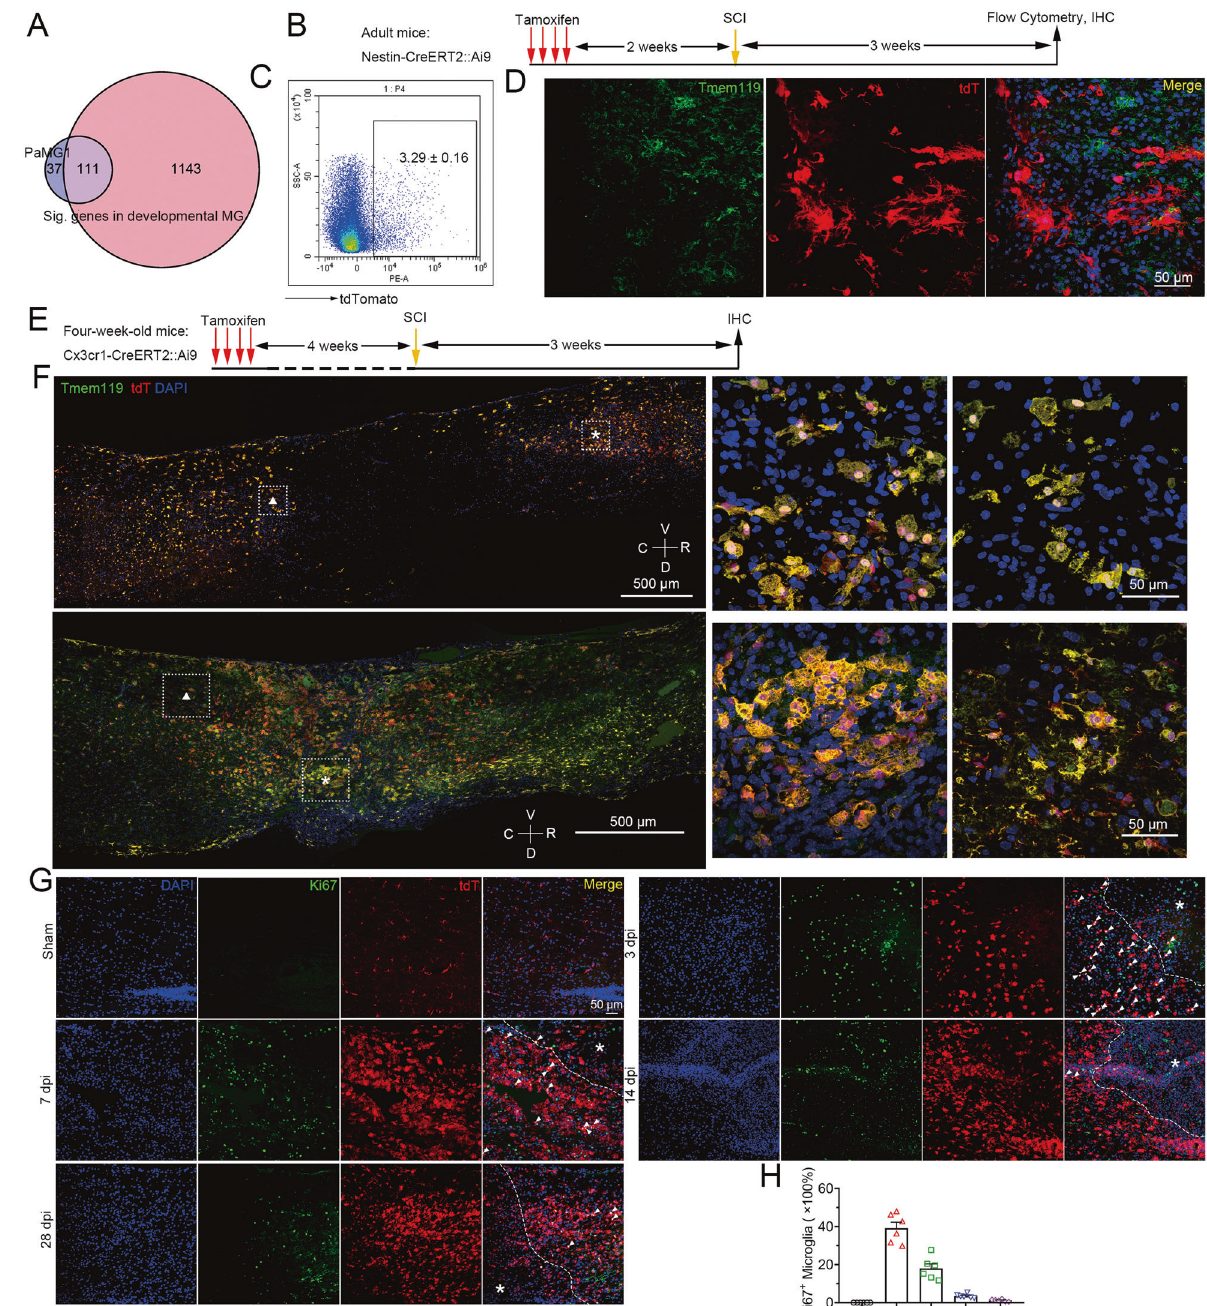
independent mice. Scale bar: 50 μ m. E Experimental scheme for genetic lineage tracing of Cx3cr1 + microglia after SCI. F IHC images show almost all microglia after SCI co-express tdT at 3 dpi (top panels) and 21 dpi (bottom panels). Magni fi ed images of the boxed area are displayed in the middle (asterisk) and right (triangle). Images indicate similar results from three independent mice. Scale bar: 500 μ m. Scale bar: 50 μ m. G IHC images show the expression of Ki67 (a proliferative marker) in microglia after SCI at 0, 3, 7, 14, and 28 dpi. Asterisk: